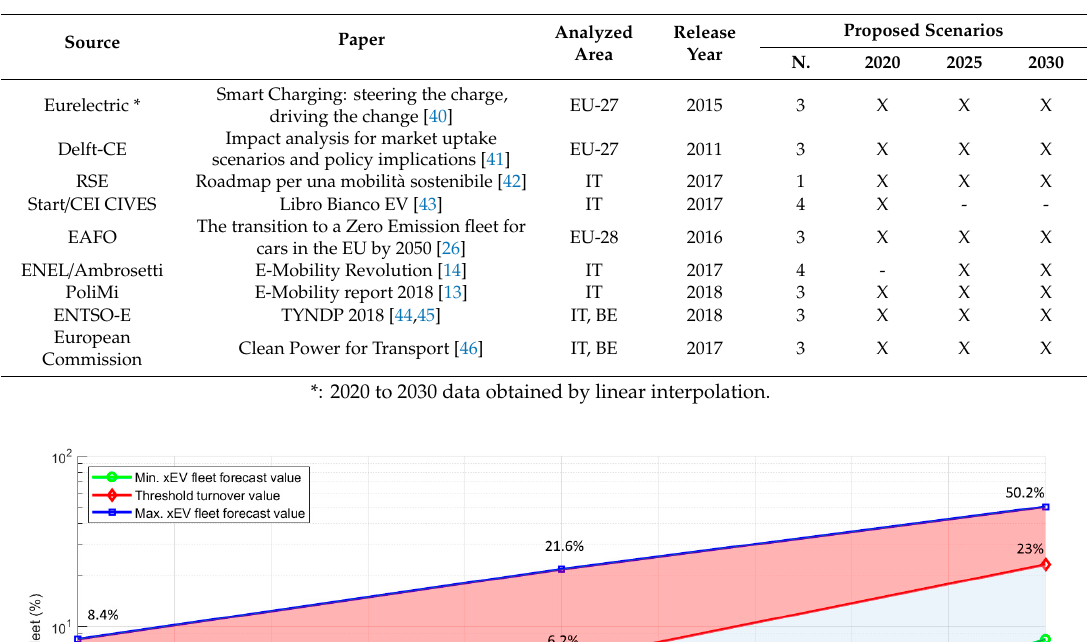
Table 3. Data sources for xEV fleet size forecasts.